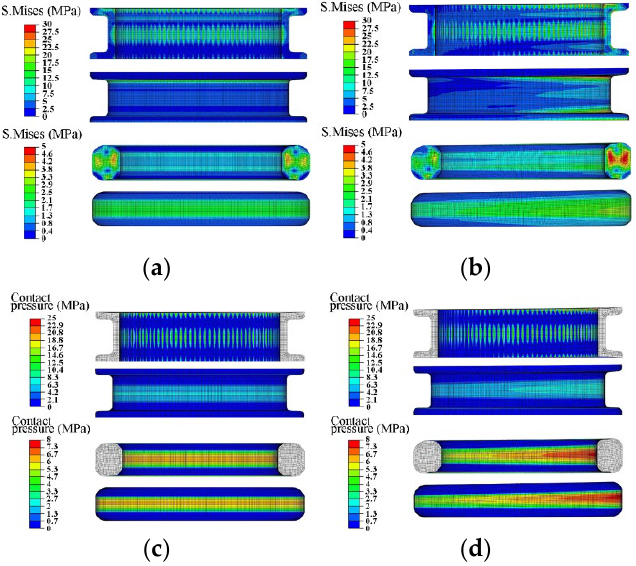
Figure 10. Stress and contact pressure distributions of Cap-seal under initial conditions. ( a , c ) δ = 0 mm; ( b , d ) δ = 0. 1 mm.